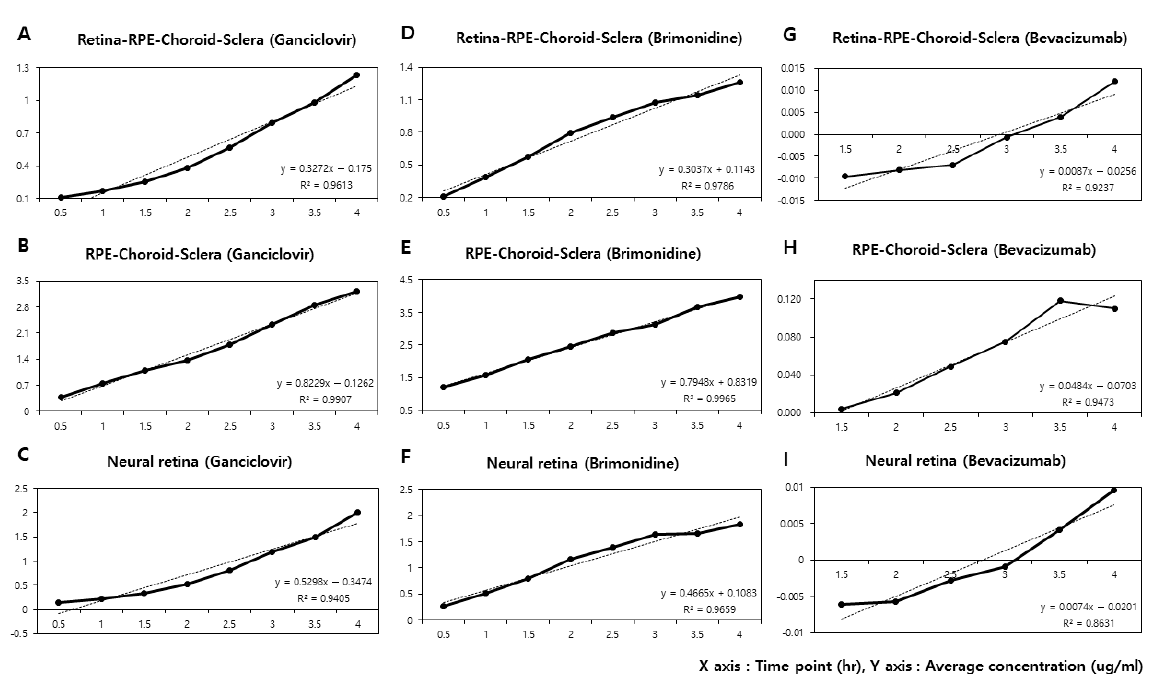
Figure 1. The average time–concentration curves of three ophthalmic drugs in two different rabbit ocular tissues: Retina- PRE-Choroid-Sclera (RCS) and RPE-Choroid-Sclera (CS), and the calculated data of the neural retina. The slope dC cates the change in the acceptor concentration between two time points, and the linear fit models and correlation coefficients (R 2 ) are documented. ( A ) RCS, brimonidine: y = 0.3037x + 0.1143 (R 2 = 0.9786); ( B ) CS, brimonidine: y = 0.7948x + 0.8319 (R 2 = 0.9965); ( C ) Neural retina, brimonidine: y = 0.4665x + 0.1083 (R 2 = 0.9659); ( D ) RCS, ganciclovir: y = 0.3272x −